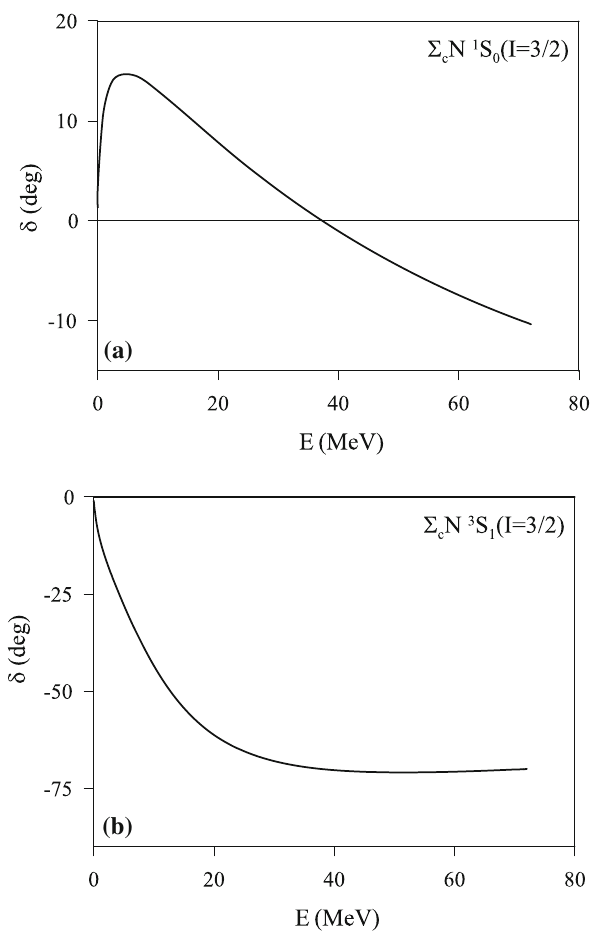
Fig. 7 a Phase shifts for the (cid:3) c N 1 S 0 ( I = 3 / 2 ) partial wave predicted by the CQM as a function of the c.m. kinetic energy. b Same as ( a ) for the (cid:3) c N 3 S 1 ( I = 3 / 2 ) partial wave